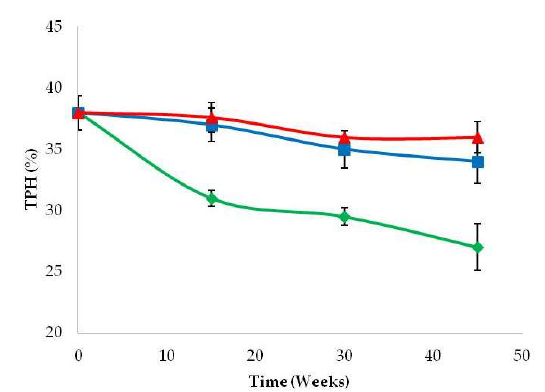
Figure 3. The rate of total petroleum hydrocarbon (TPH) during 45 days of treatment. Treatment with carrot peel waste ( ); Treatment with carob ( ■ ); and Control without treatment ( ▲ ). Error bars represent the standard error of replicates.